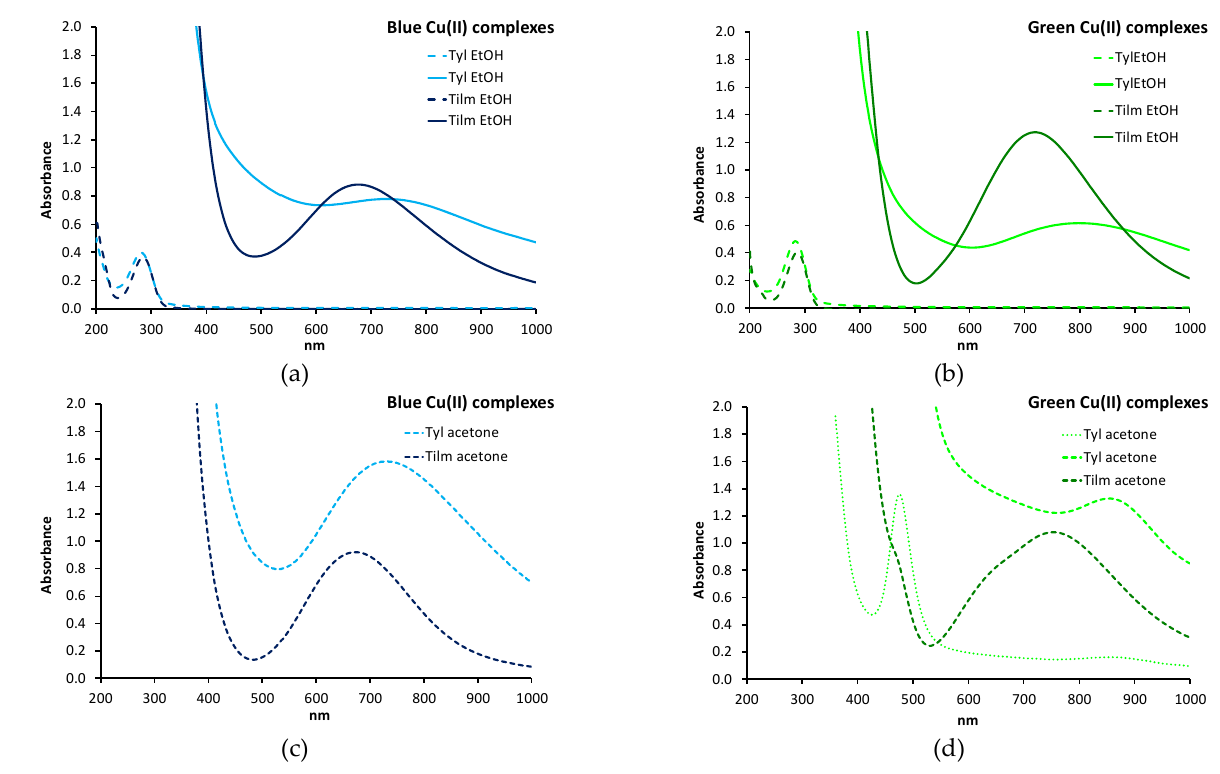
Figure 1. Absorption spectra of the isolated copper(II) blue ( a , c ) and green ( b , d ) macrolide complexes solved in ethanol ( a , b ) and acetone ( c , d ). Taking into account the dominating presence of the dinuclear species, the concentrations of the compounds were as follows: 10 –5 M (EtOH, 200–400 nm) and 10 –2 M (EtOH, acetone, 400–1000 nm), while the green complexes in acetone were measured at Table 1. Extinction (a max ) and molar extinction (ε max ) coefficients of tylosin base, tilmicosin base and their copper(II) complexes determined by the standard curve approach (R 2 > 0.99).